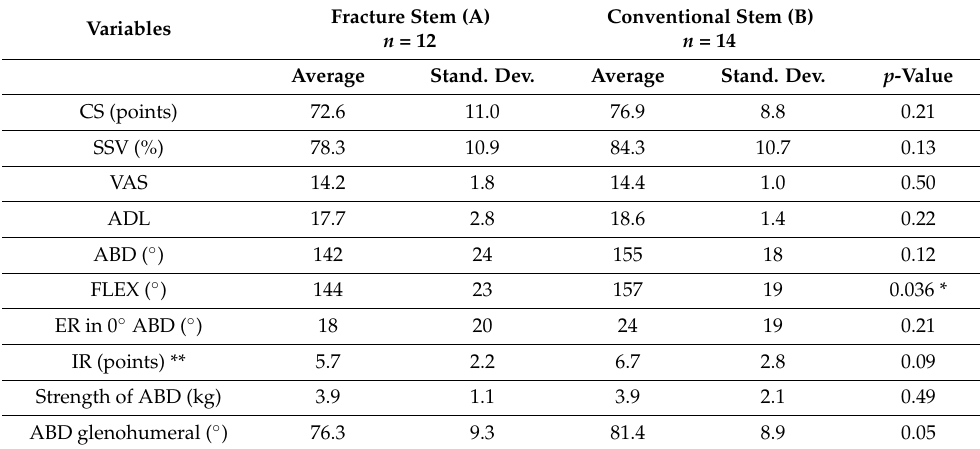
Figure 6. A 70-year-old female patient presents at a six-year follow-up GT resorption in true a/ p radiograph ( a ). Three years later, further resorption of the lateral cortex of the proximal humerus (*) has occurred ( b ). She was not entirely pain-free (VAS 2/15), however, presented excellent clinical function in abduction ( c ) and internal rotation ( d ). Better results in forward flexion, abduction, and SSV but also more pain is associated with this cortex resorption ( p < 0.05). Table 2. Comparison of clinical results at the final follow-up for both groups.